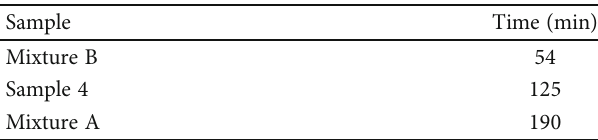
Figure 8: The evaluation and comparison of mixture A, mixture B, and sample 4. Table 4: Time to reach the emission limit of 2.4g samples